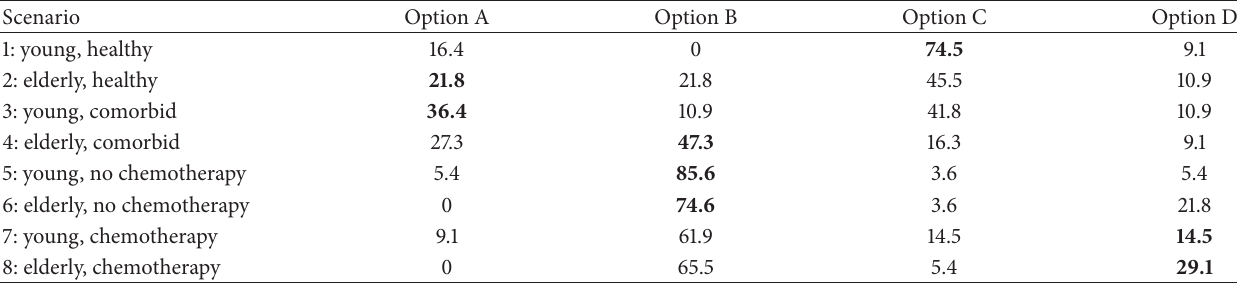
Table 3: A subgroup of respondents’ management decisions (measured in proportions, %) based on eight clinical scenarios of malignant large bowel obstruction or MLO (detailed in Box 1), with the optimal approach highlighted in bold, as suggested by the 2014 ESGE/ASGE guidelines. Only the therapeutic choices of respondents who were exposed to at least five cases of MLO in the previous twelve months are shown here.